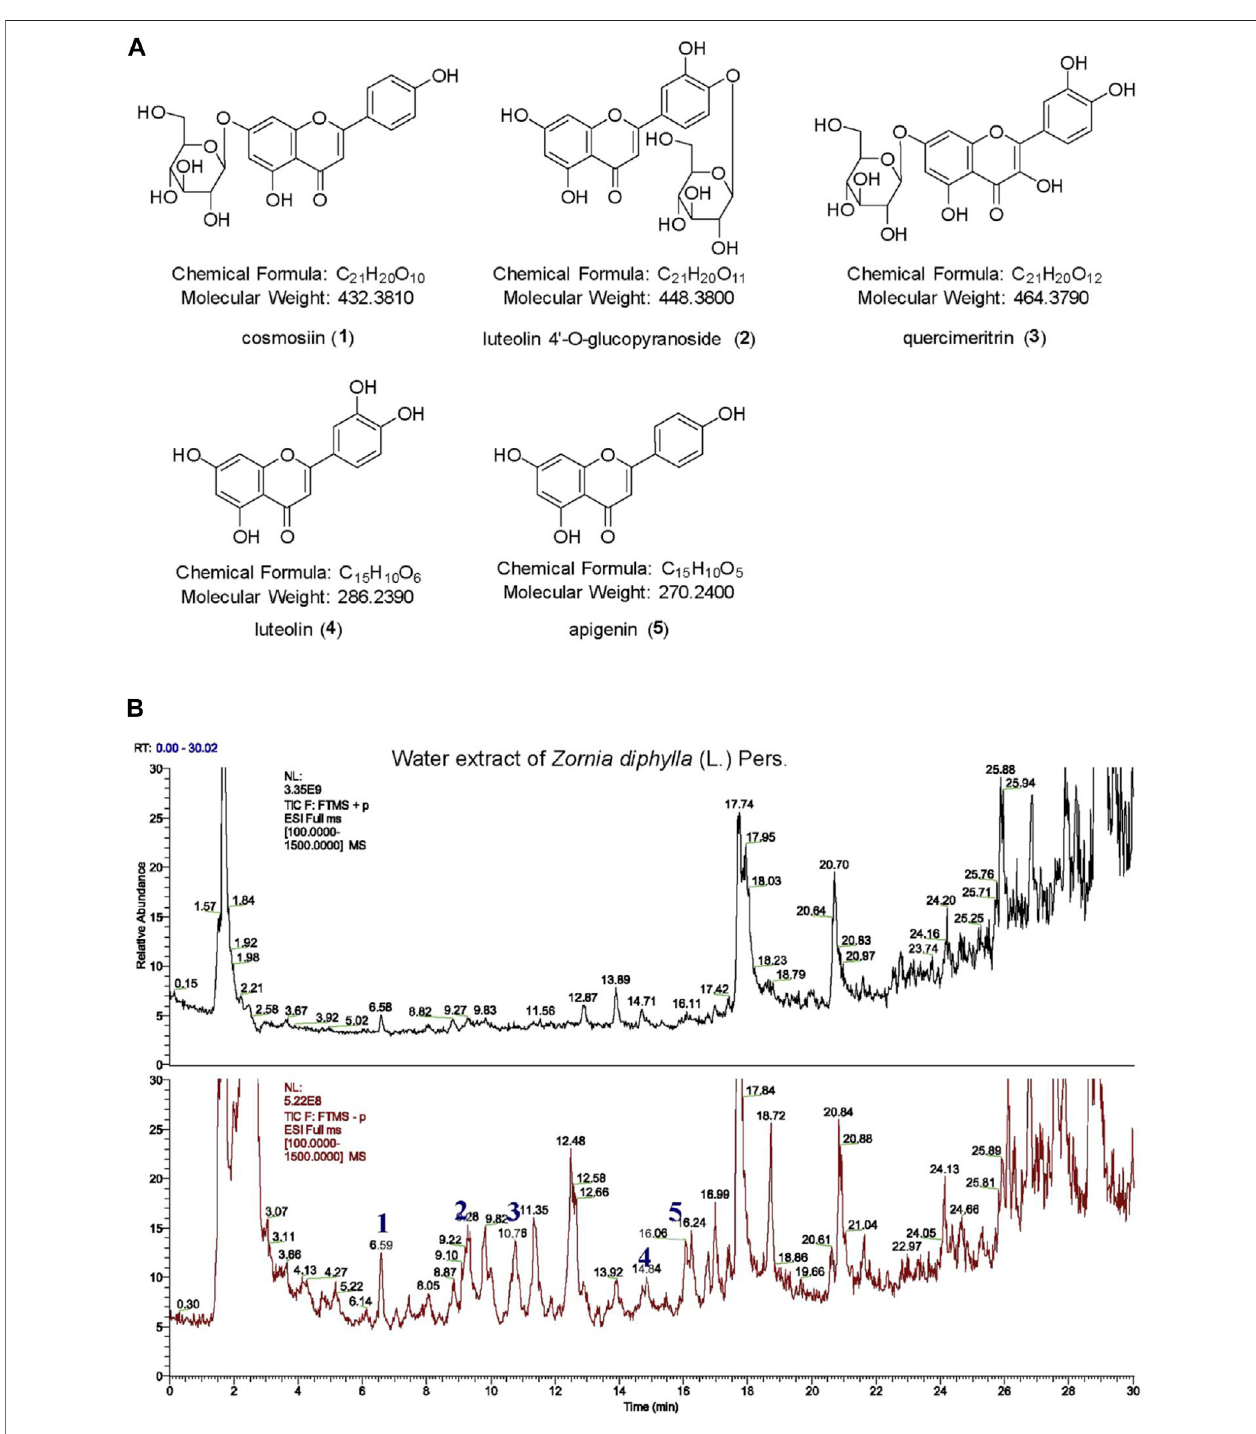
FIGURE 1 | HPLC-HR ESI MS analysis of a water extract from the herb of Zornia diphylla (L.) Pers. (A) Chemical structures of the major identi fi ed components of ZDP: cosmosiin (1), luteolin 4 ′ -O-glucopyranoside (2), quercimeritrin (3), luteolin (4) and apigenin (5). (B) HPLC-MS spectra fi ngerprint of ZDP. Upper: positive mode (+); lower: negative mode ( −